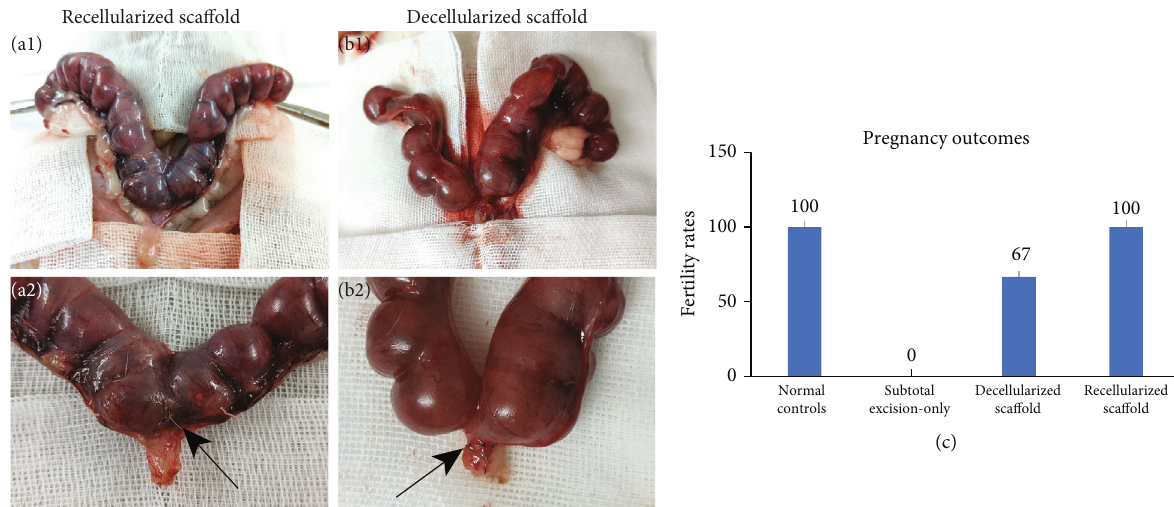
Figure 7: Pregnancy outcomes of fertility test. Positive pregnancy outcomes in recellularized sca ff old (a1, a2) and decellularized sca ff old (b1, b2) groups. The implantation sites can be indicated by visible sutures. Black arrows indicate the surgical sites of the cervixes. The fi gure shows the fertility rate of four groups (c).